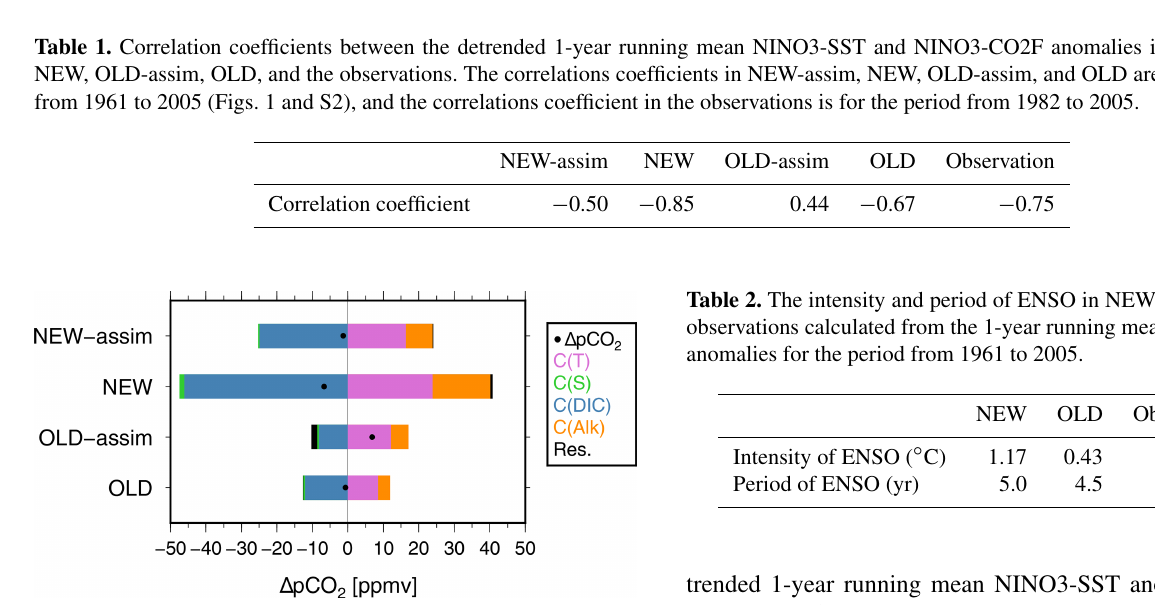
Figure 2. Changes in p CO 2 regressed onto the standardized NINO3-SST anomalies ( (cid:49)p CO 2 ) (dots) and its decomposition with changes in X ( X = T , S , DIC, Alk), C( X ), and Res. (Eq. 3) evalu- ated in NEW-assim, NEW, OLD-assim, and OLD. See the text for details regarding the calculation of (cid:49)p CO 2 , C( X ), and Res.